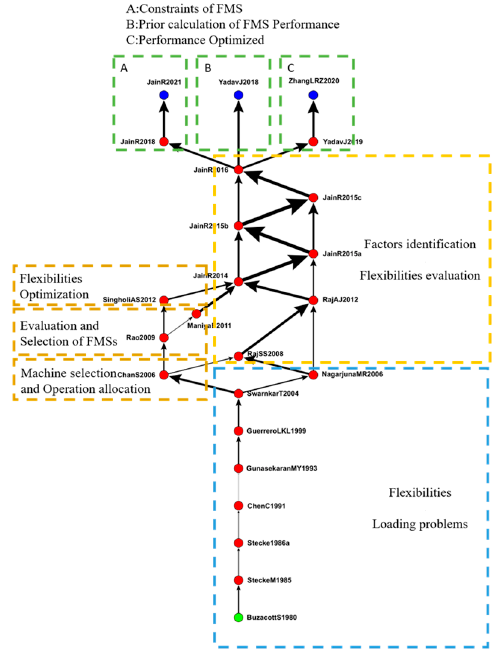
Figure 4. Key-route main path of FMS research.